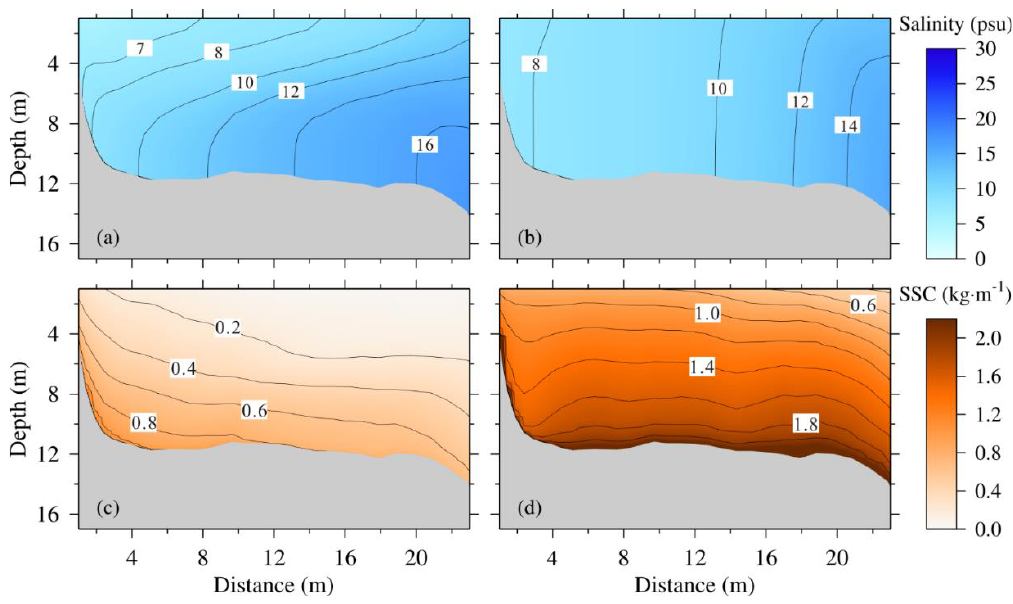
Figure 14. Vertical profile distributions of salinity ( a , b ) and SSC ( c , d ) along the section from Nanhui Cape to Qiqu Archipelago during neap tide (left panel) and spring tide (right panel) in summer.